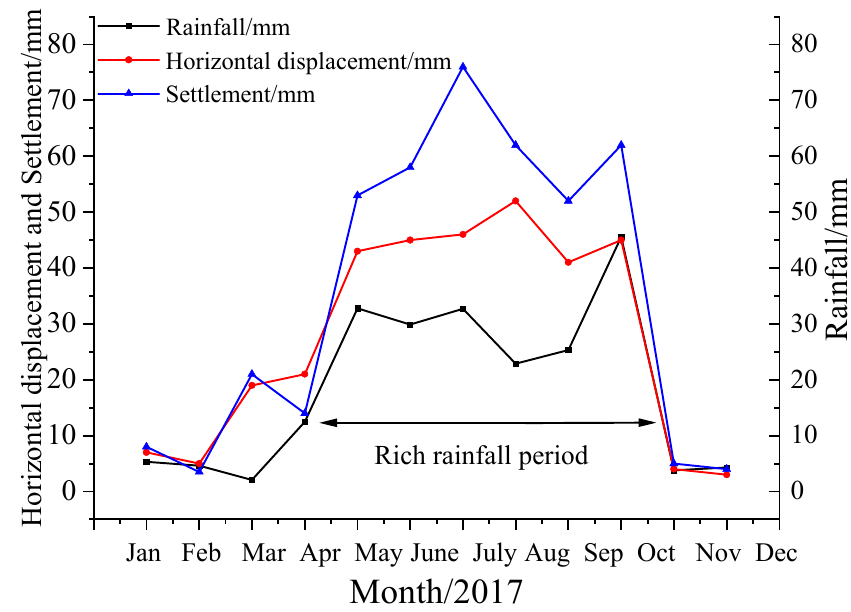
Figure 6. Rainfall and displacement curves of the north end slope in 2017.